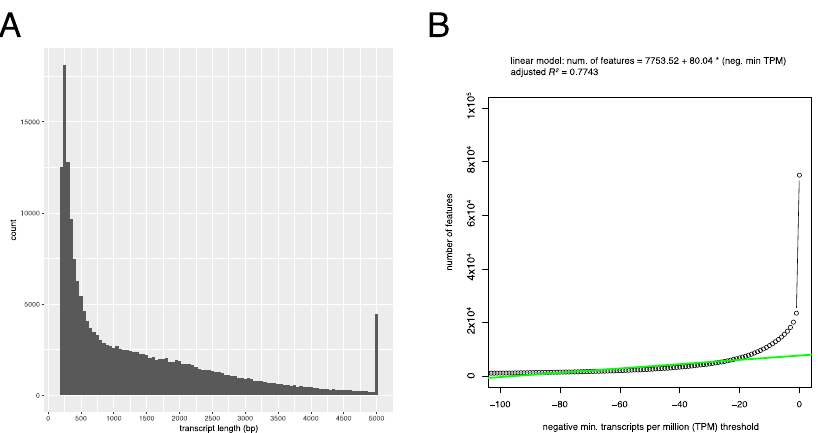
Figure 3. Assembly transcript length distribution and estimation of expressed transcripts. a. Assembly transcript length distribution. ( A ) Histogram shows the binned counts of the lengths of individual transcripts represented by 50 bp bins. Sequences with length greater than 5000 were binned together. Plotted as circles are the number of transcripts with a minimum transcripts per million (TPM) value in any one sample at each threshold (plotted as negative values). A linear regression model fit to values between –100 and –10 neg. min. TPM is shown as a green line. The y-intercept (7753.52) indicates the estimated number of expressed transcripts supported by the sequenced